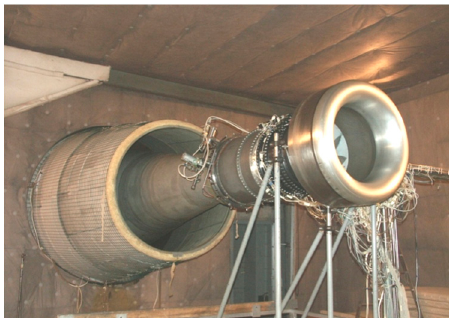
Figure 2. C-3A acoustic test facility with the anechoic chamber, without turbulence control screen (TCS).